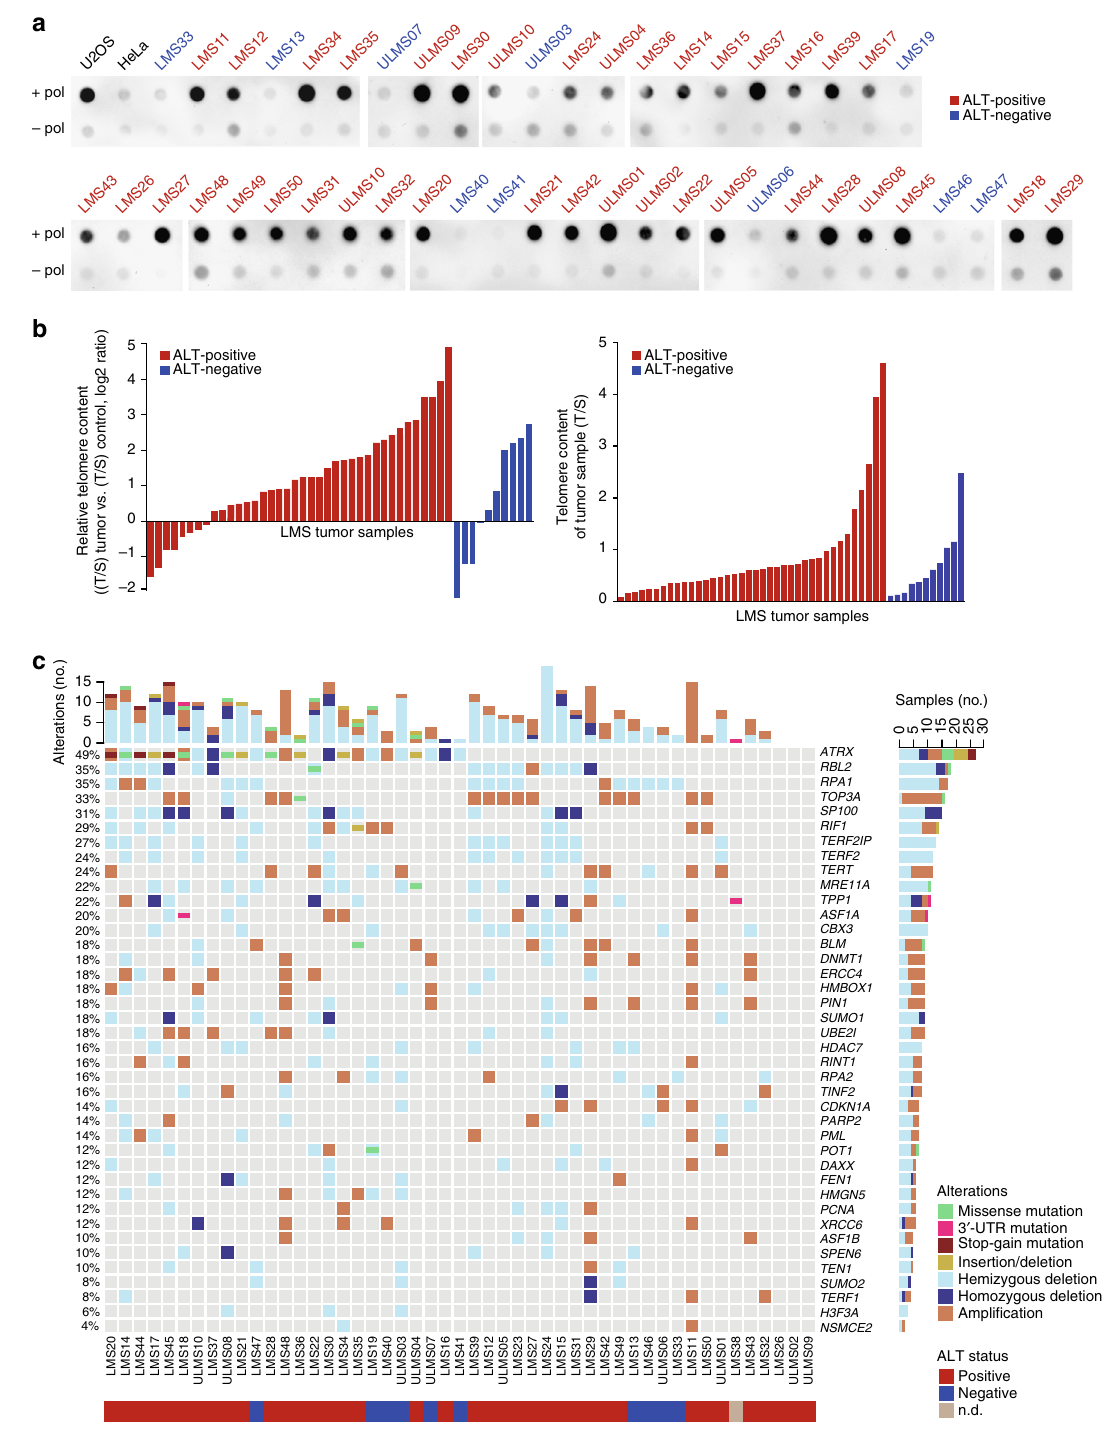
Fig. 6 High frequency of alternative lengthening of telomeres (ALT) in adult LMS. a Detection of C-circles in LMS tumors and control cell lines (U2OS, positive control; HeLa, negative control). Shown are test samples (top row) and control samples (bottom row). ALT-positive samples, as inferred from the enriched C-circle signal, are indicated in red. ALT-negative samples are indicated in blue. +pol, with polymerase; − pol, without polymerase. b Measurement of telomere content in LMS tumors. Telomere quantitative PCR was performed on tumor and matched control samples, and telomere repeat signals were normalized to a single-copy gene ( 36B4 ; T/S ratio). Shown are the telomere contents of tumor samples relative to those of control samples (left) and the absolute telomere contents of tumor samples (right). c Recurrent alterations in telomerase maintenance genes in LMS tumors. Rows represent individual genes, columns represent individual tumors. Genes are sorted according to frequency of SNVs, indels, and CNAs (left). Bars depict the number of alterations for individual tumors (top) and genes (right). Types of alterations and ALT status are annotated according to the color codes (bottom). UTR untranslated region; n.d. not